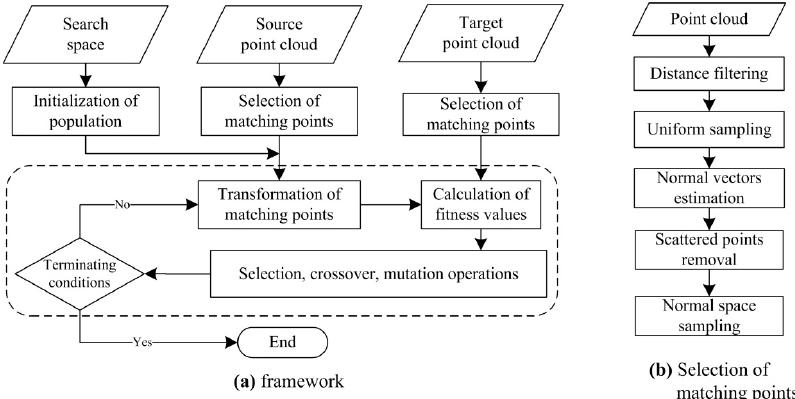
Figure 1. The framework and selection of matching points of the proposed GA registration. The GA evolution is showed in the dashed box. ( a ) The flow chart of GA registration; ( b ) The process of selection of mathing points.